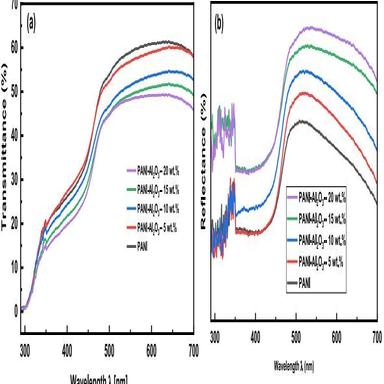
(a) Transmittance and (b) reflectance spectra of the PANI and PANI-Al2O3 nanocomposite films.